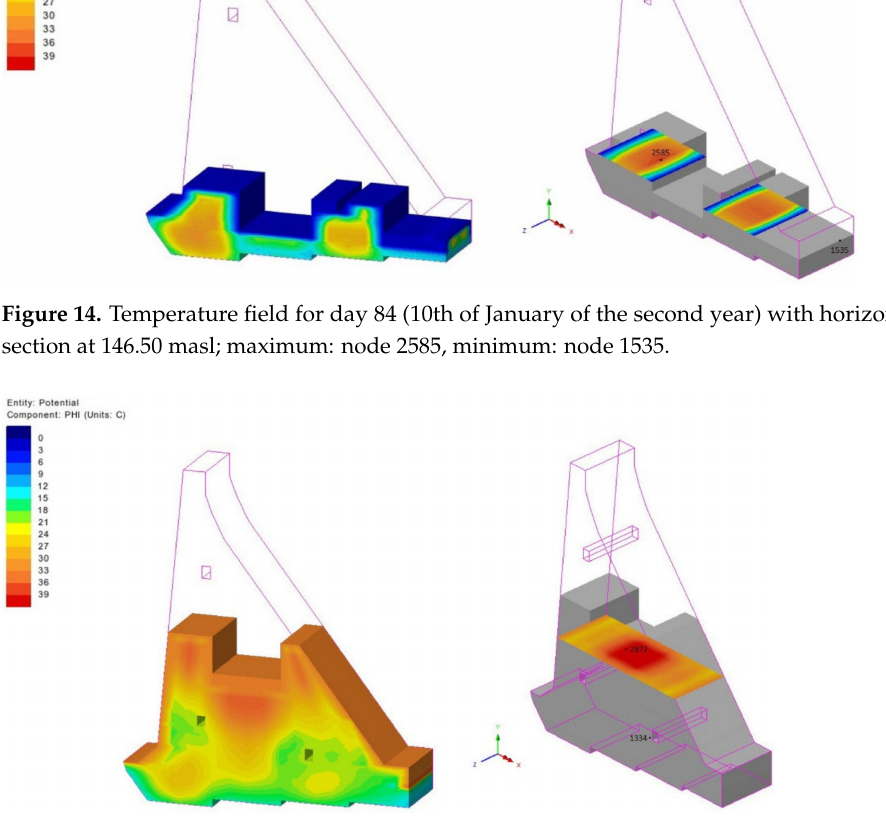
Figure 15. Temperature field for day 283 (27th of July of the second year) with horizontal cross-section at 169.0 masl; maximum: node 2872, minimum: node